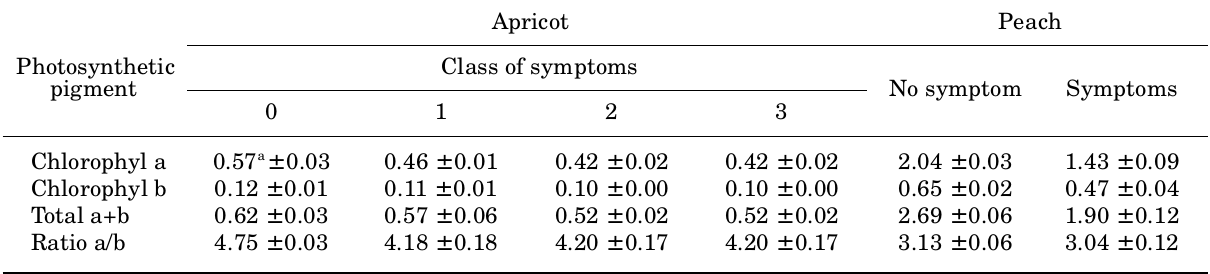
Table 1. Content of photosynthetic pigments in apricot and peach leaves infected with plum pox virus. Apricot Peach Photosynthetic Class of symptoms pigment No